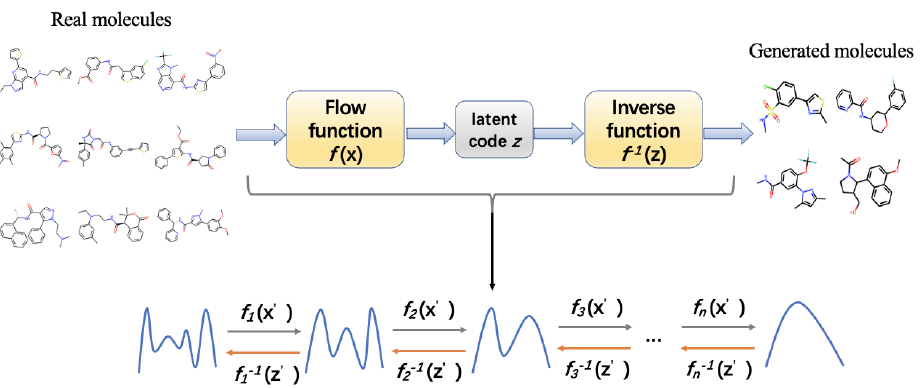
Figure 7. Architecture of normalizing flows. It contains a series of invertible functions for transform- ing molecular data into simple distribution and converting the distribution into high-dimensional molecular data for de novo drug design. Each of the functions optimizes the data distribution. The normalizing flow architecture has been used in certain molecule generation mod- els. MolFlow is a flow-based graph generative model that exploits normalizing flow to map molecular graphs and latent representations. It trains a model to generate bonds and a novel graph conditional flow to generate atoms on the basis of the bonds by leveraging graph convolution operations. Finally, the bonds and atoms are assembled in bond-va- lence constraints. They also train a multilayer perceptron model for mapping between latent vectors and molecular properties [229]. The hierarchical normalizing flow model, called MolGrow, generates a molecule from a single node and recursively splits every node into two; these operations are invertible and use graphical representation for node and edge attributes and feed them into an L invertible level architecture, wherein the gen- erated latent codes fit into Gaussian distribution. Each level contains multiple blocks and linear transformations for noise separation and node merging; inside each block, three channel-wise transformations and two RealNVP layers are present [245]. GraphDF is a discrete latent variable model that applies normalizing flow for molecule generation. These discrete latent variables are sampled from multinomial distributions, and the model